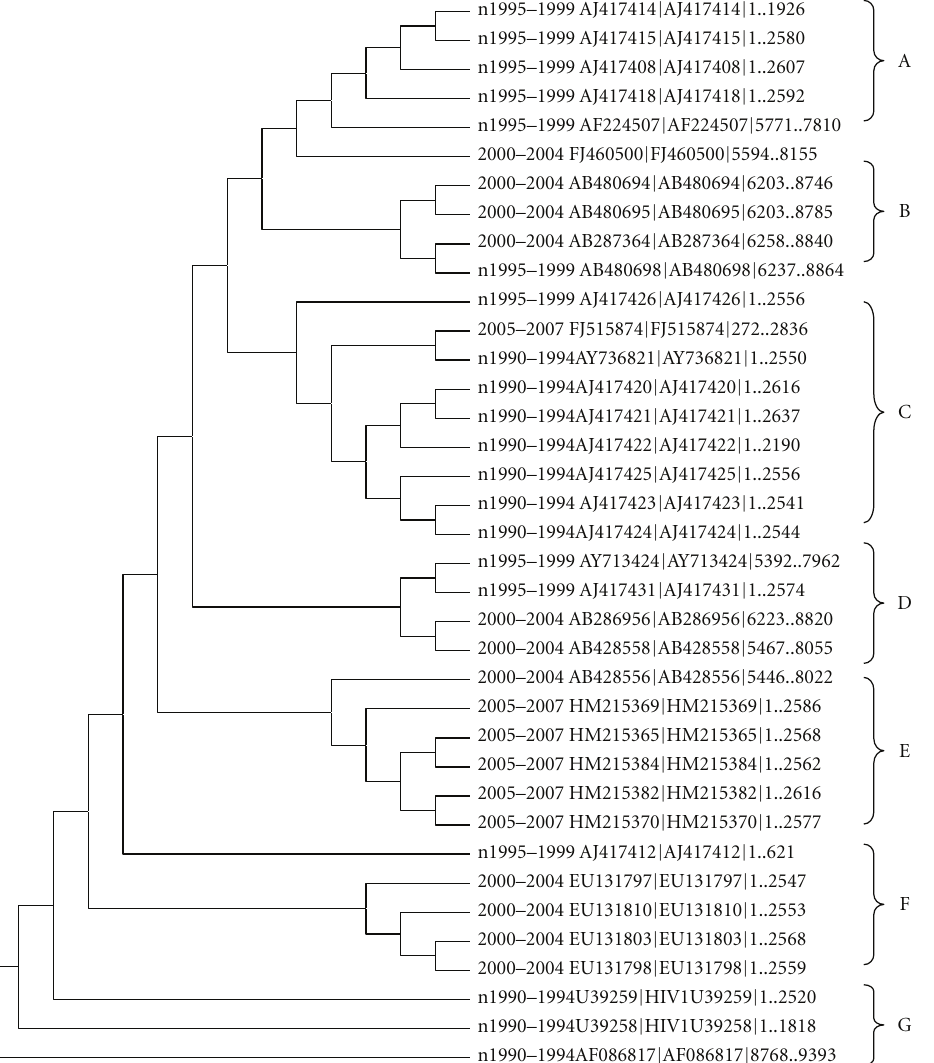
Figure 1: Neighbour-joining phylogenetic tree (constructed using MEGA 5) based on amino acid sequences of envelop protein from HIV-1 subtype B in